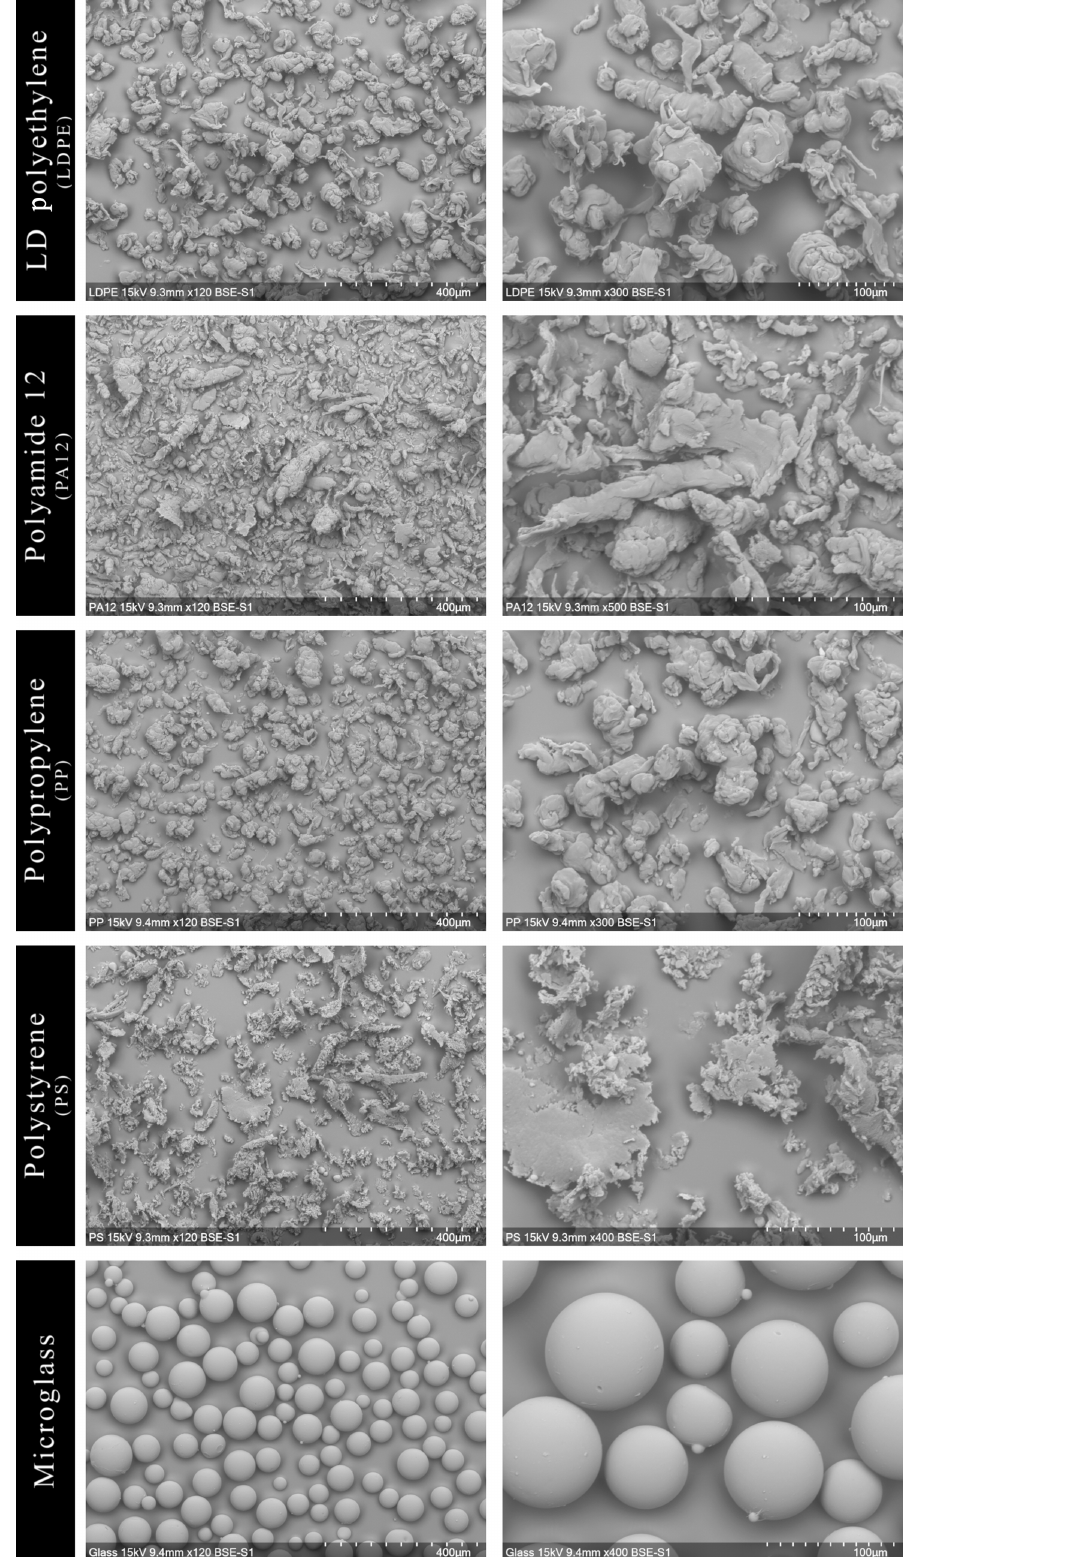
Figure 1. Heterogenic particle size distribution and morphology depending on the microparticle type visualized by the scanning electron microscopy